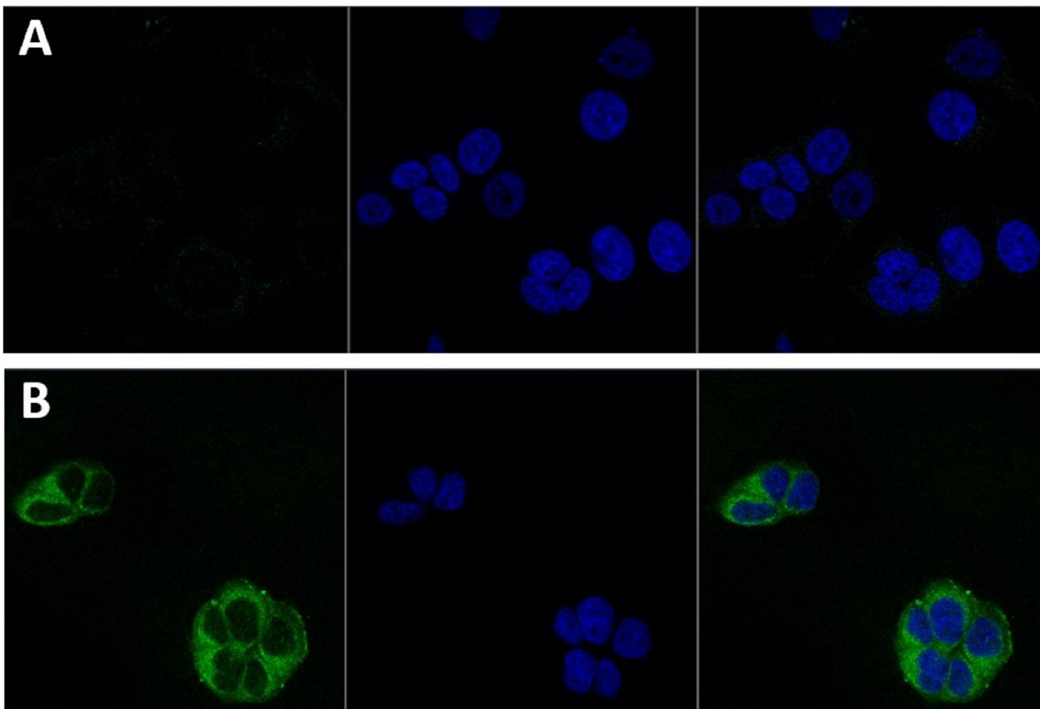
Figure 2. Intracellular localisation of CS-NP in MCF-7 cells as determined by light scattering confocal microscopy. ( A ) Cells with rhodamine 123 alone. ( B ) Cells after three hours of exposure to CS-NP. In both rows, the left panel shows the cytoplasmic distribution of the CS-NP (green); the middle panel shows the 4′,6-diamidino-2-phenylindole (DAPI ) -stained nuclei, and the right panel shows the merge image. All the images were taken at 63× magnification.